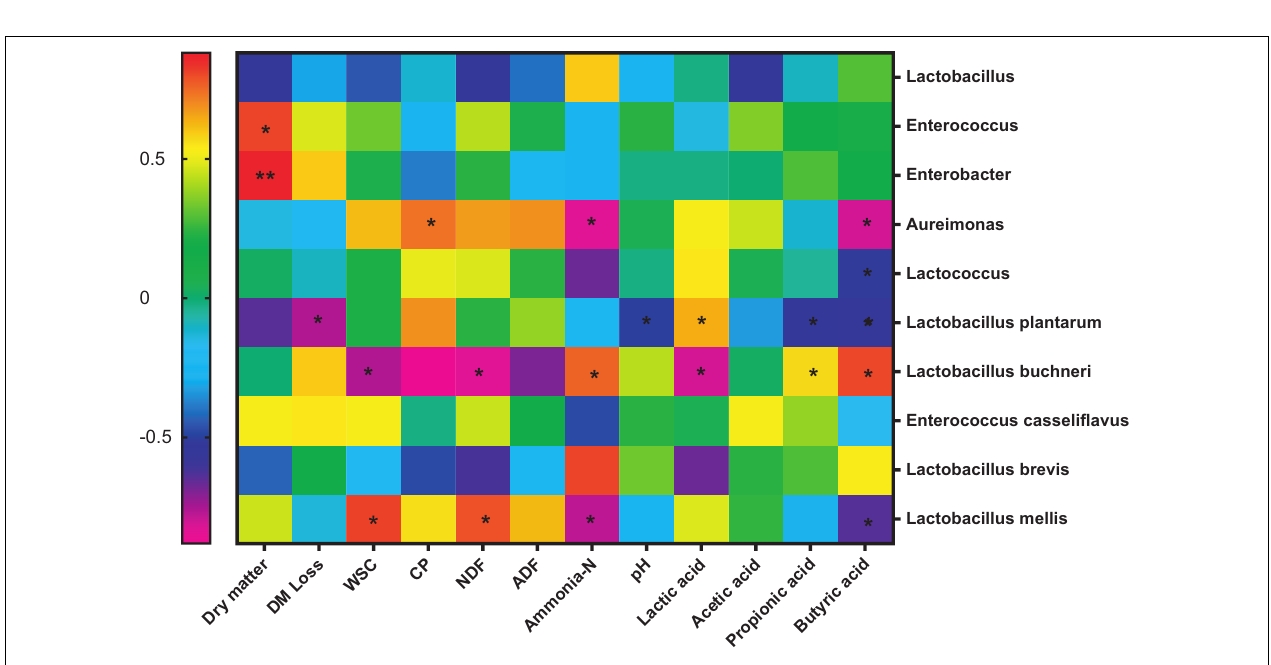
FIGURE 3 | Spearman correlation between chemical compositions and relative abundances of top five genera and species in silage. * P < 0.05, ** P < 0.01.